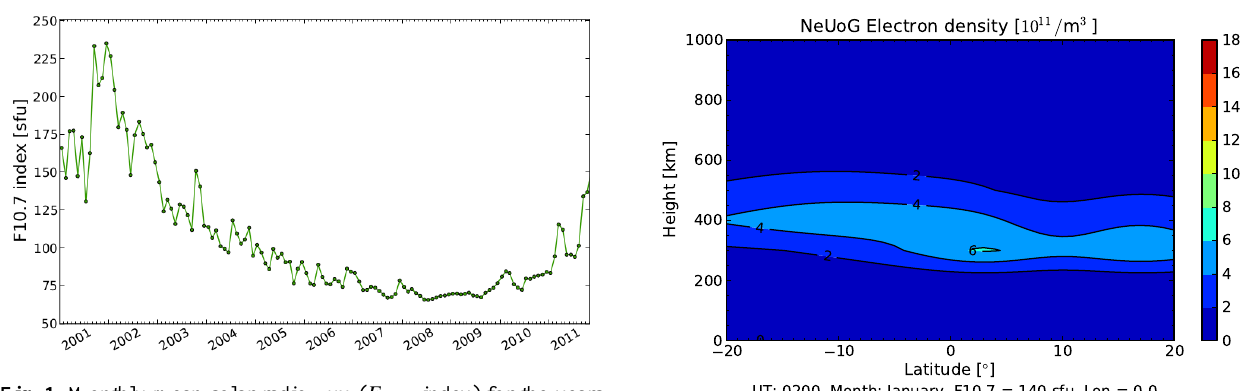
Fig. 1. Monthly mean solar radio flux ( F 10 . 7 index) for the years 2001 to 2011 (1sfu = 10 − 22 Wm − 1 Hz − 1 ).